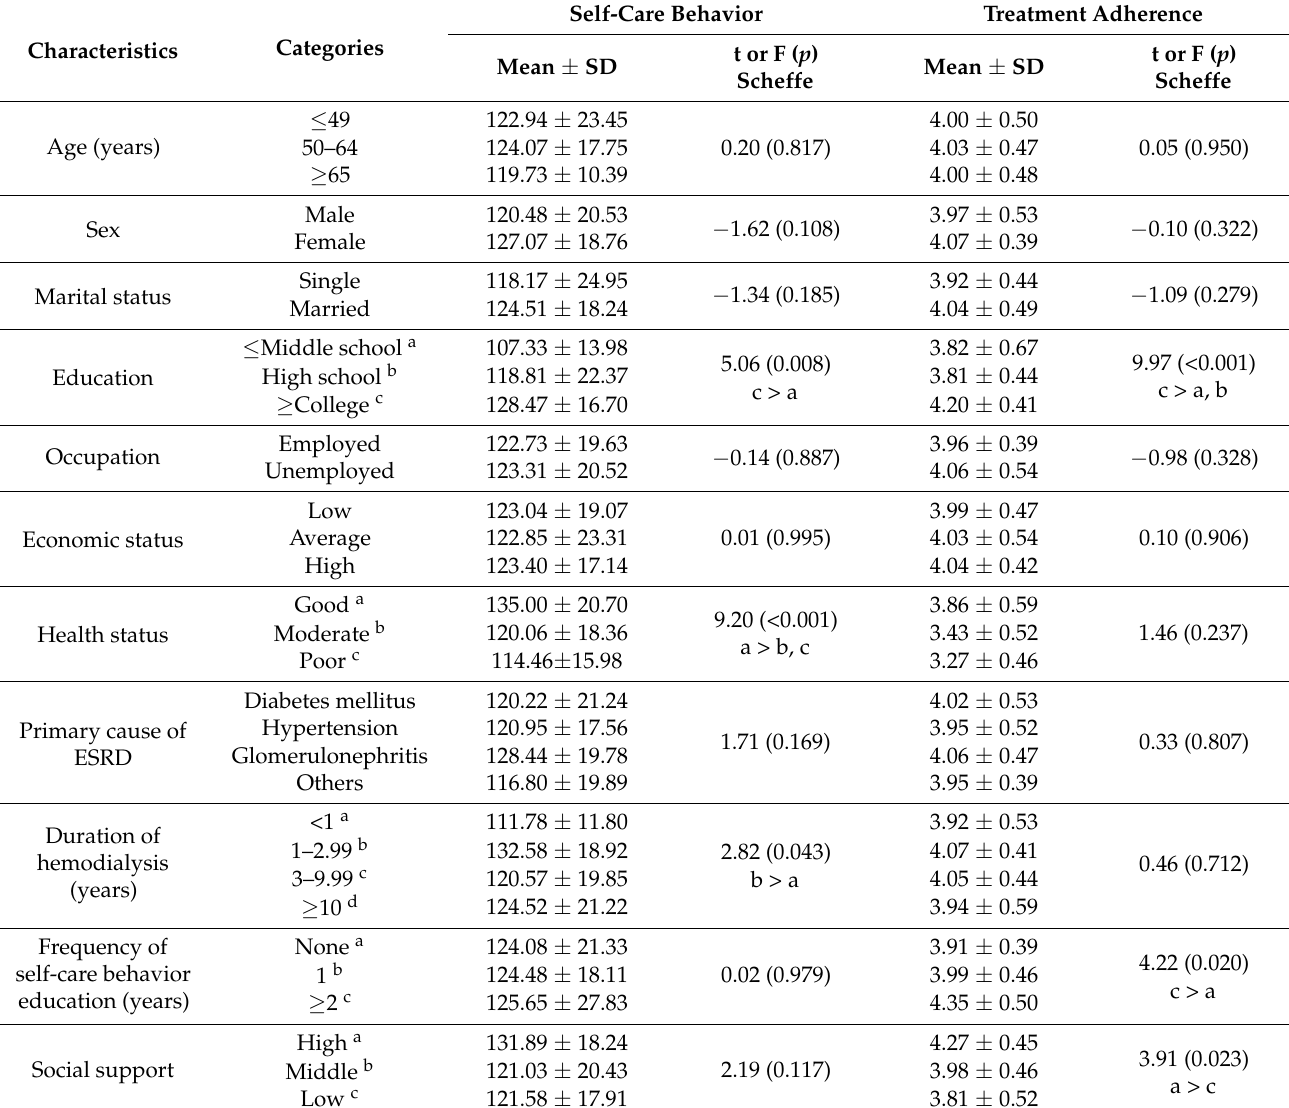
Table 3. Differences in self-care behavior and treatment adherence according to patient characteristics ( n = 100).